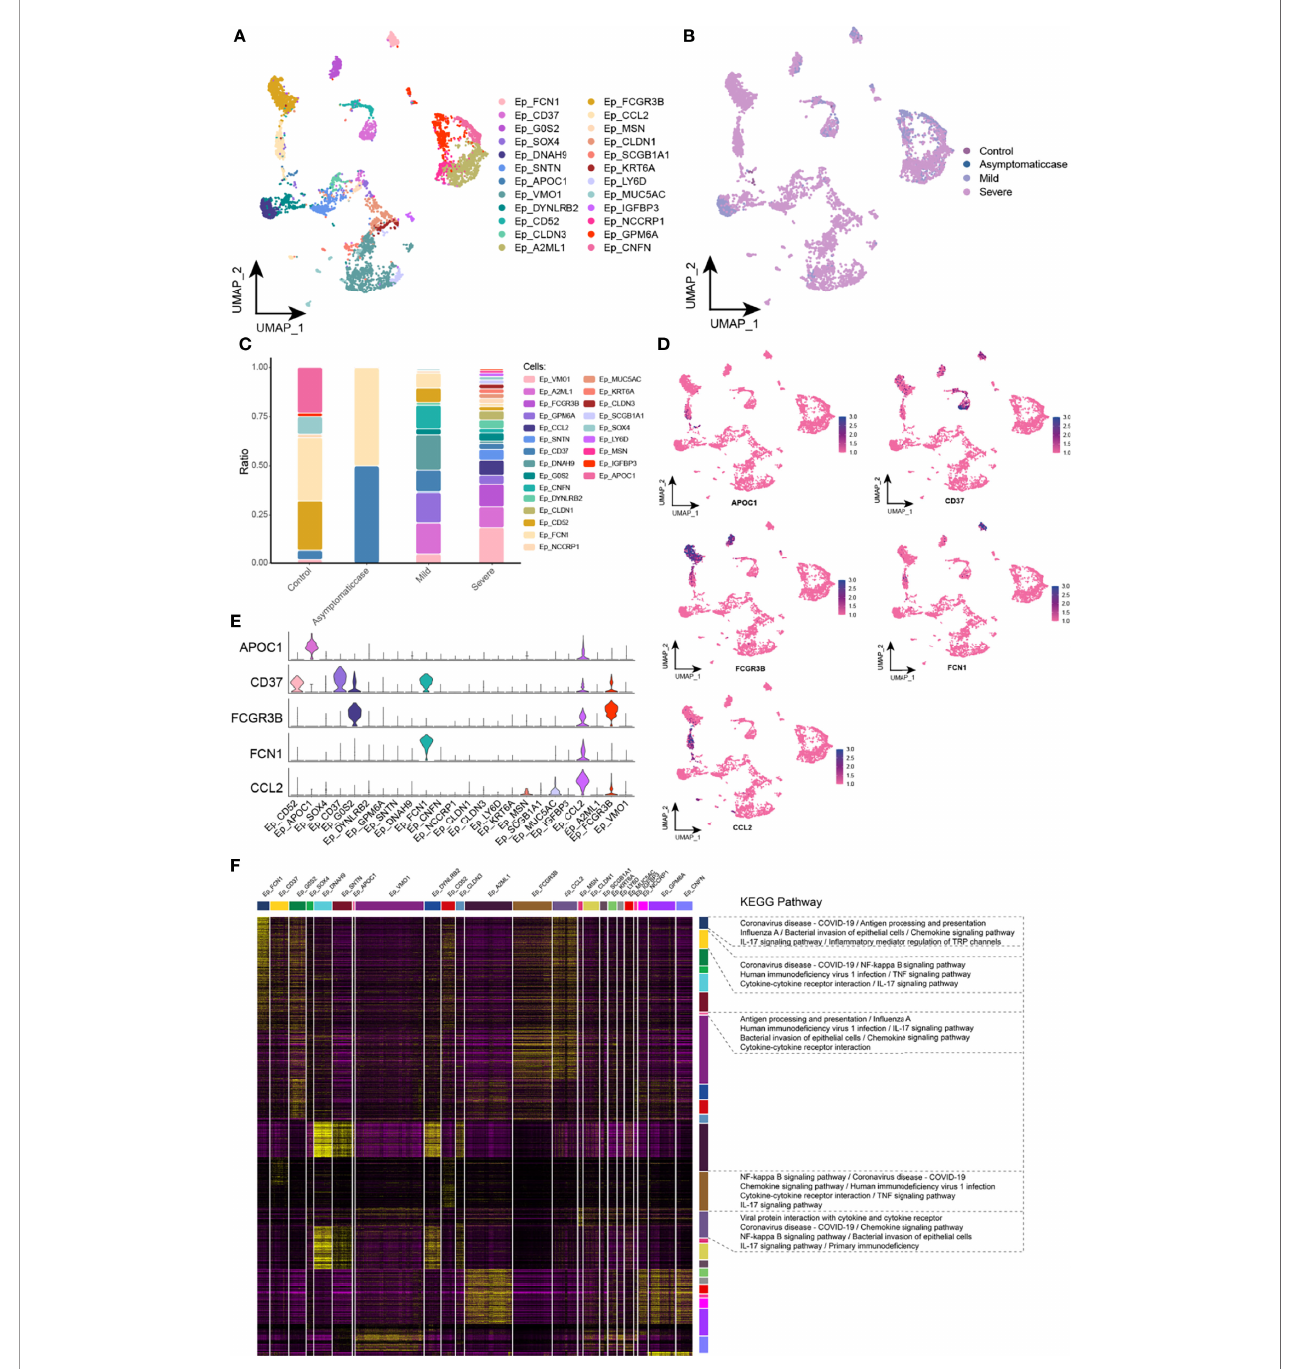
FIGURE 3 | Abnormal components of epithelial cell in patients with COVID-19. (A) Single-cell mapping of EP cell subsets. (B) Single-cell mapping of EP cells in the COVID-19 courses. (C) Components and changes of epithelial cell subsets in the courses of new crowns. (D, E) Expression of marker genes in subsets of EP cells. (F) Biological pathways involved in subsets of EP cells with speci fi c changes. EP, epithelial cell; KEGG, Kyoto Encyclopedia of Genes and Genomes; UMAP, Uniform Manifold Approximation and Projection for Dimension